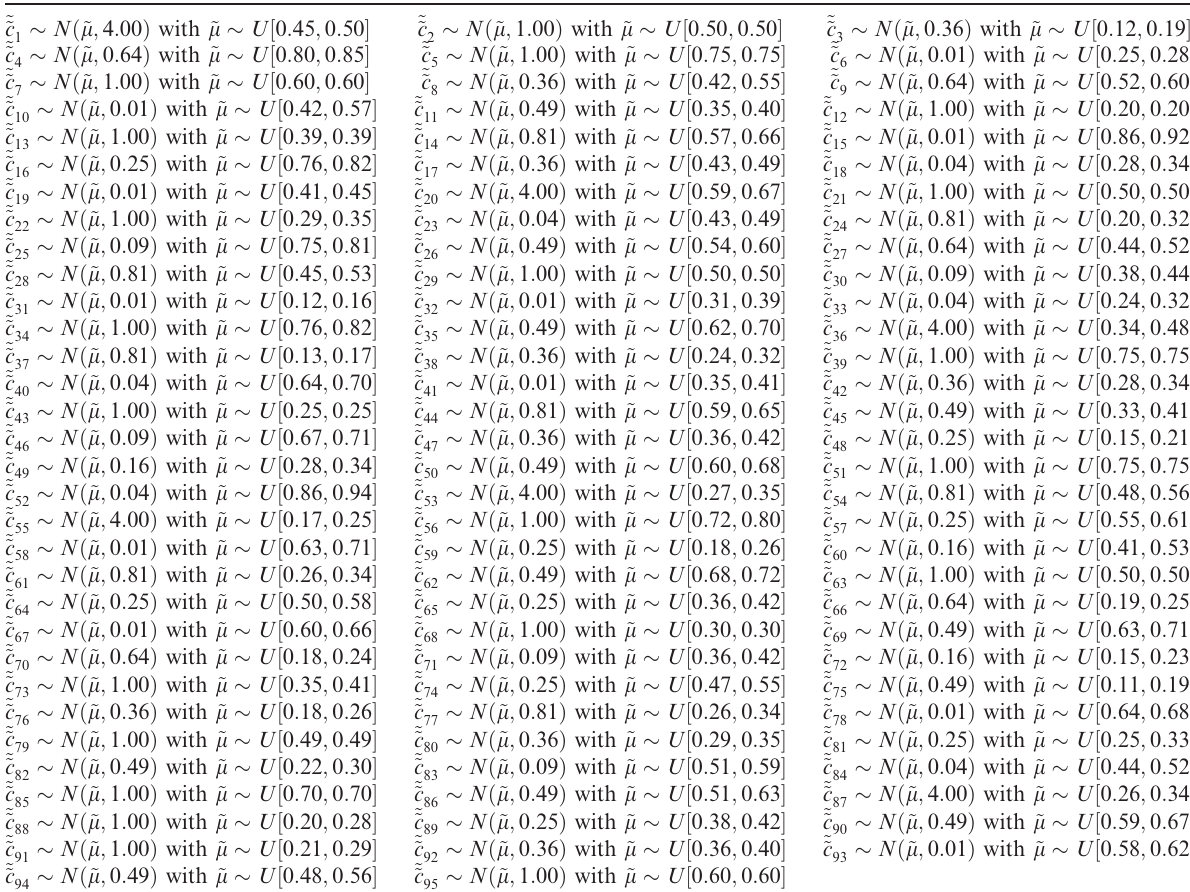
Table 1. The penalty coefficients of waiting time for ship